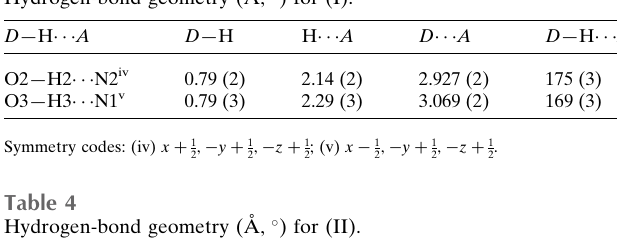
Table 3 Hydrogen-bond geometry (A˚ , (cid:5) ) for (I).